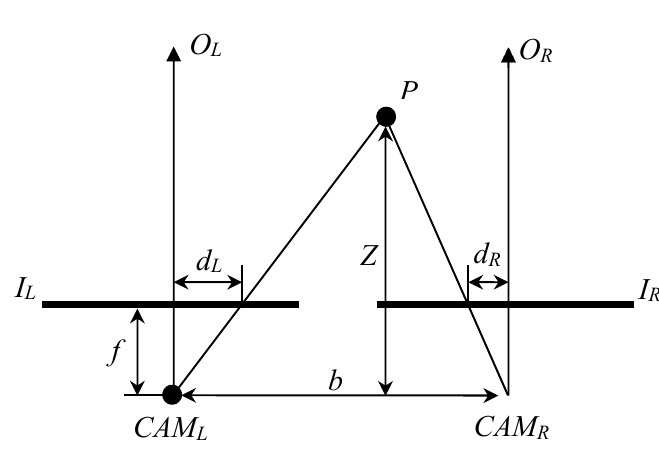
Figure 1. Schematic diagram of a three-dimensional model with disparity.